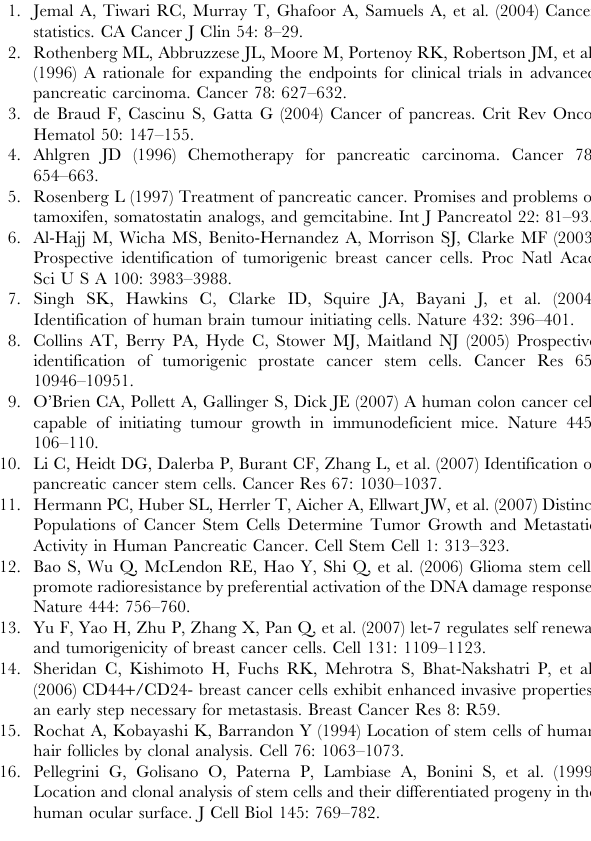
Table S1 Primers for real-time PCR of genes. Table S2 Primers for real-time PCR of microRNAs. Table S3 Tumorgenecity of distinct types of colonies derived from PC3 cell